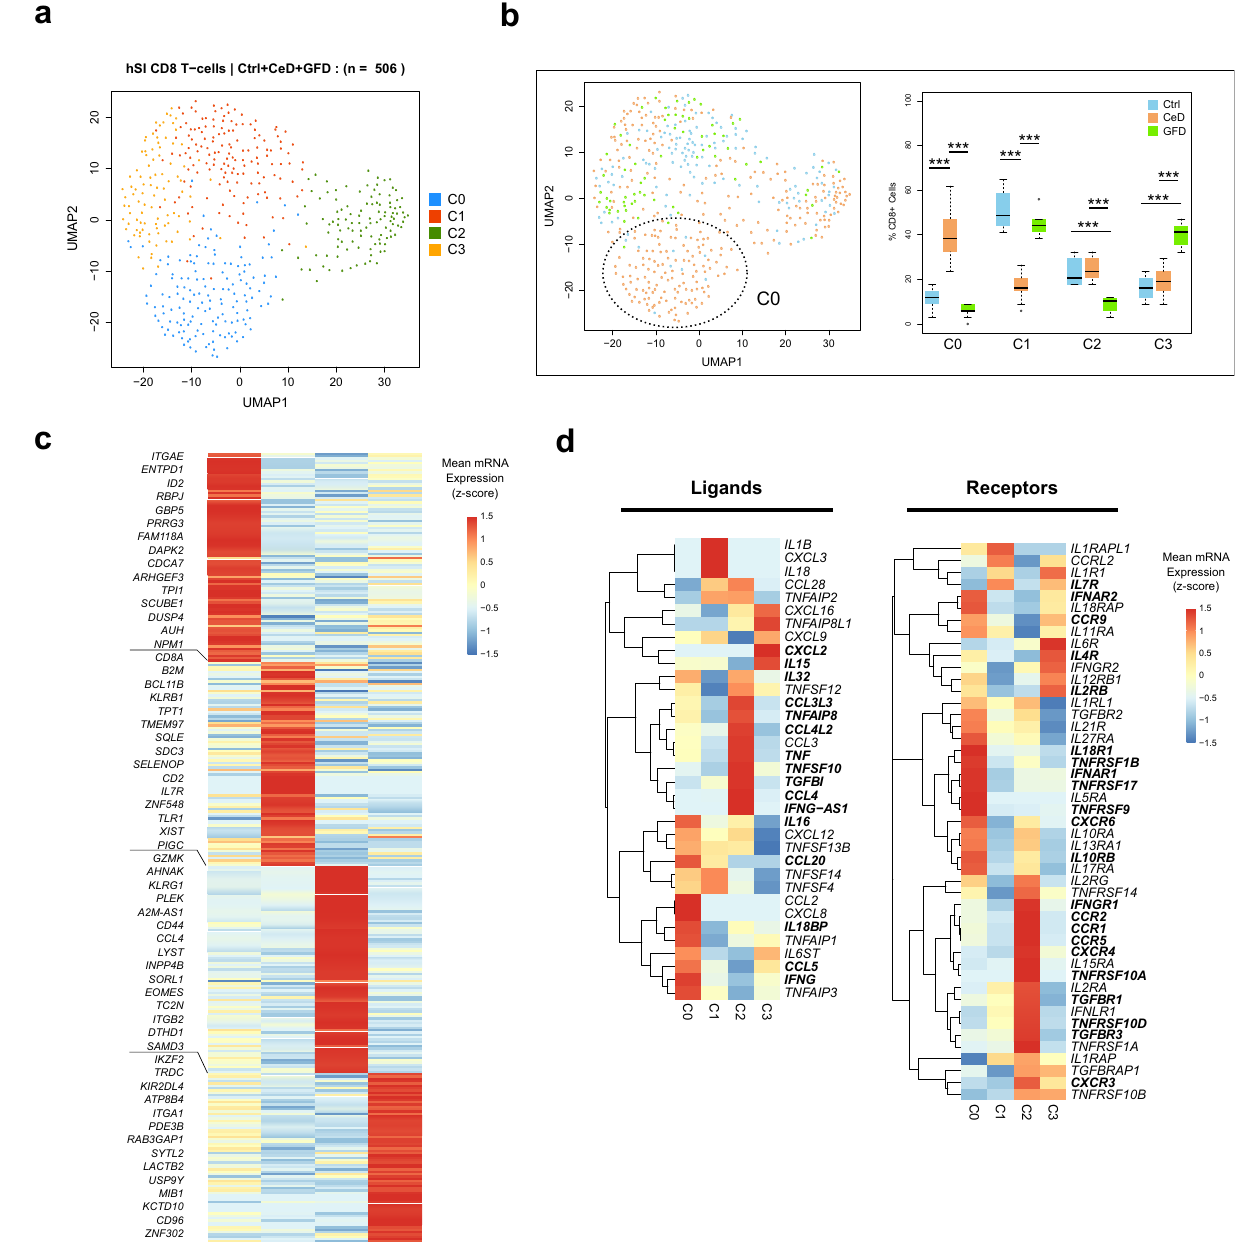
Fig. 5 | Single-cell landscape of CD8 + T cells in Lamina Propria of human small intestine from Ctrl, CeD and GFD samples. a UMAP clustering depicting the heterogeneity of CD8 + T cells in Lamina Propria (LP) from Ctrl (control subjects), CeD(Celiacdiseasepatients)andGFD(Celiacpatientsongluten-freediet)samples. b Projection of cells according to Ctrl, CeD and GFD origin on the UMAP clusters (left scatter plot) and the boxplots showing the distribution of cells across the clusterspereachconditionascompared to eachother(right)(center line, median; box limits, upper and lower quartiles; whiskers, minimum and maximum values; points,outliers,1.5xinterquartilerange;two-sidedt-test p value<=0.05(C0:Ctrlvs